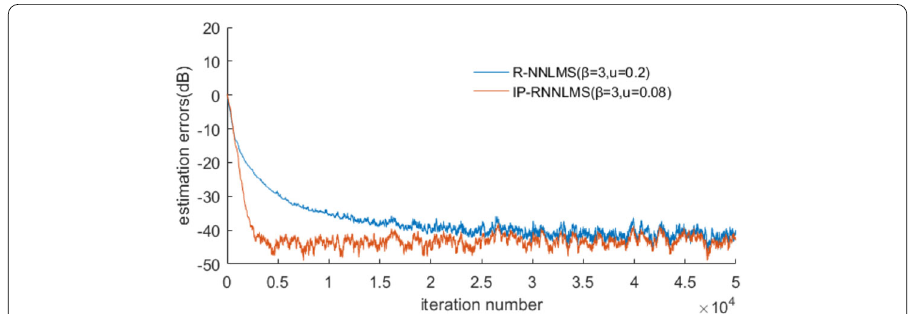
Figure 6 Estimated error of the IP-RNNLMS and R-NNLMS algorithms in SNR = 10dB